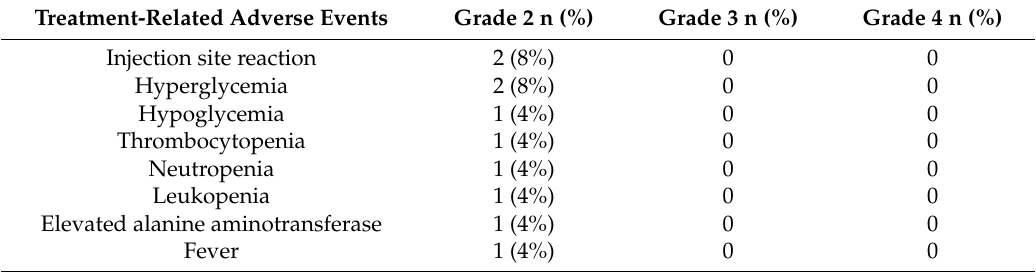
Table 2. Patients per maximum toxicity grade for ě grade 2 treatment-related events ( n = 24).